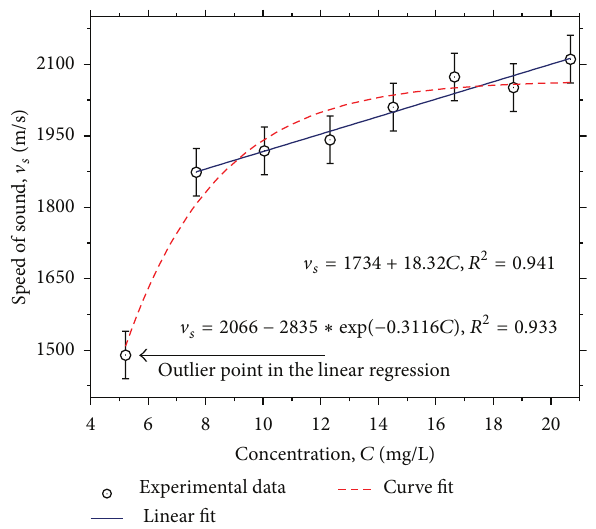
Figure 5: Speed of sound evaluated as functions of the CV-dye concentration in H 2 O based dissolutions via the